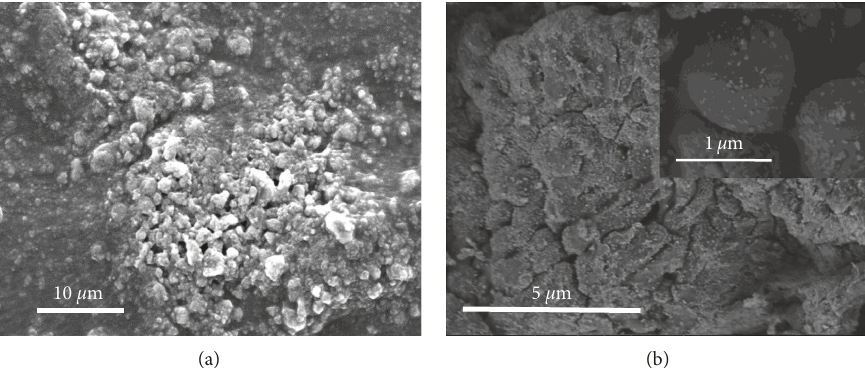
Figure 1: FESEM images of (a) neat alumina and (b) 10wt.% alumina blended by jet milling with PSU powder, and the inset corresponds to alumina nanoparticles decorating the PSU particles surfaces at different magnifications.